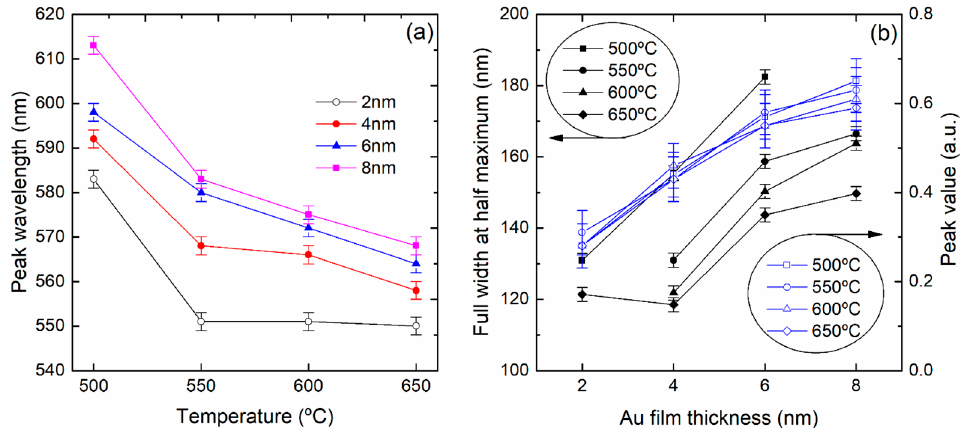
Figure 8. Evolution of the plasmonic band as a function of the annealing temperature for 2, 4, 6 and 8 nm gold thin film: ( a ) peak wavelength and ( b ) full width at half maximum and peak intensity.